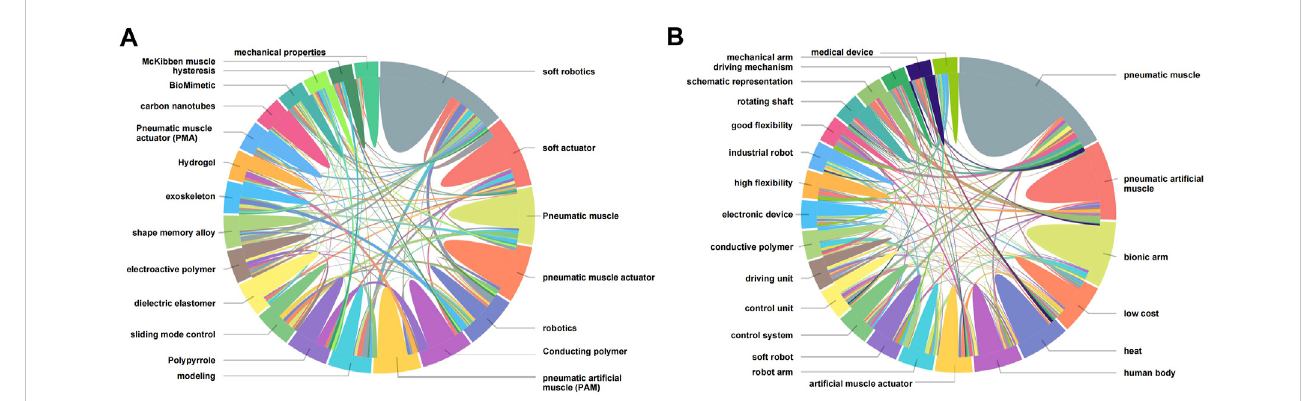
FIGURE 5 Pie map of the top 20 terms of arti fi cial muscle (A) author keywords of papers; (B) abstract NLP of